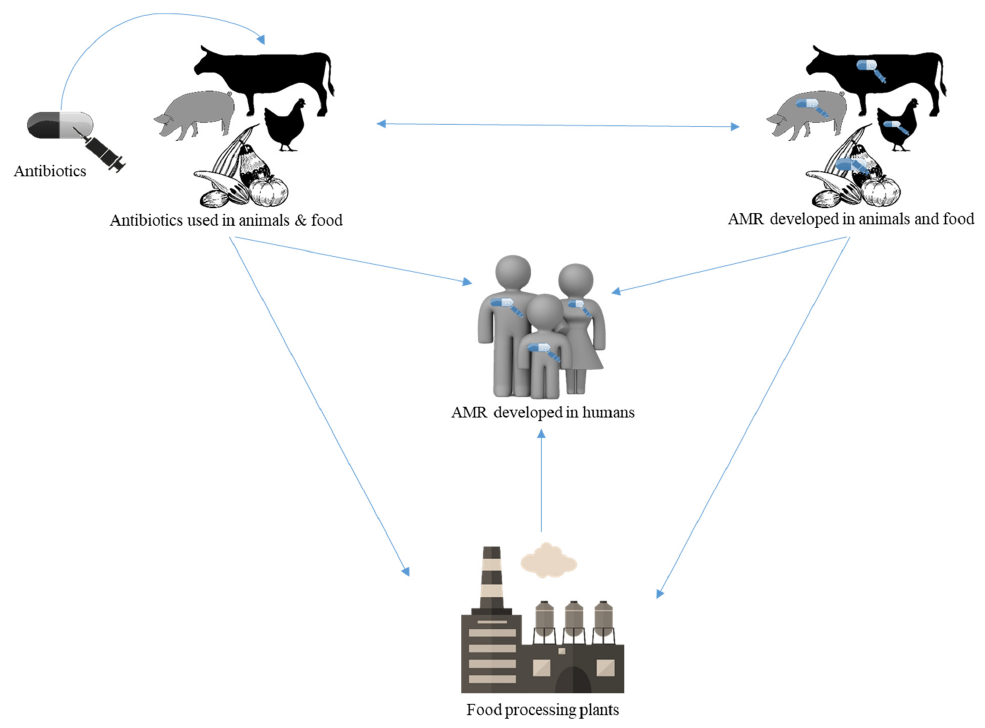
Figure 1. Relationship between antibiotic usage and antimicrobial resistance development in animals and humans through food chain.